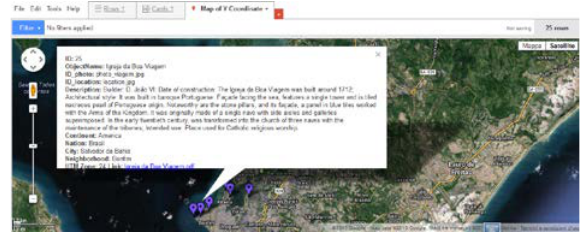
Figure 11. Dissemination on web by Fusion Tables in